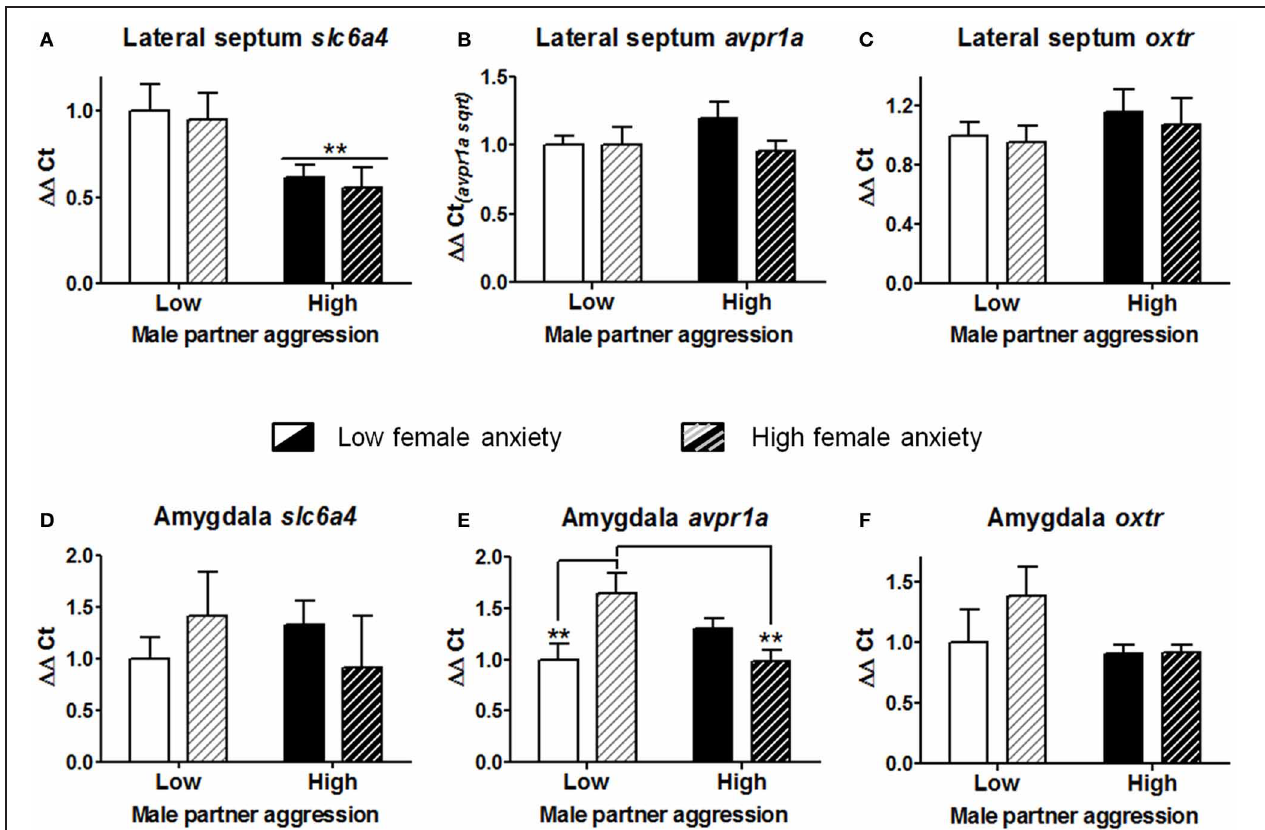
Females that had exhibited lower exploration of the open arms in the elevated plus-maze (i.e., “high” vs. “low” anxiety) exhibited a higher level of expression of this gene, yet this augmentation was blunted with sustained partner aggression. In contrast, no significant alterations were observed for oxtr in these regions. The mean ± standard error of the mean are presented. Sqrt, square